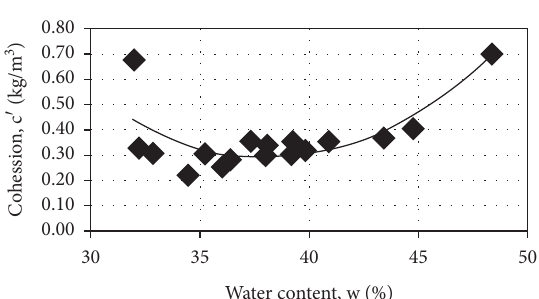
Figure 4: Highest cohesion value-added water.